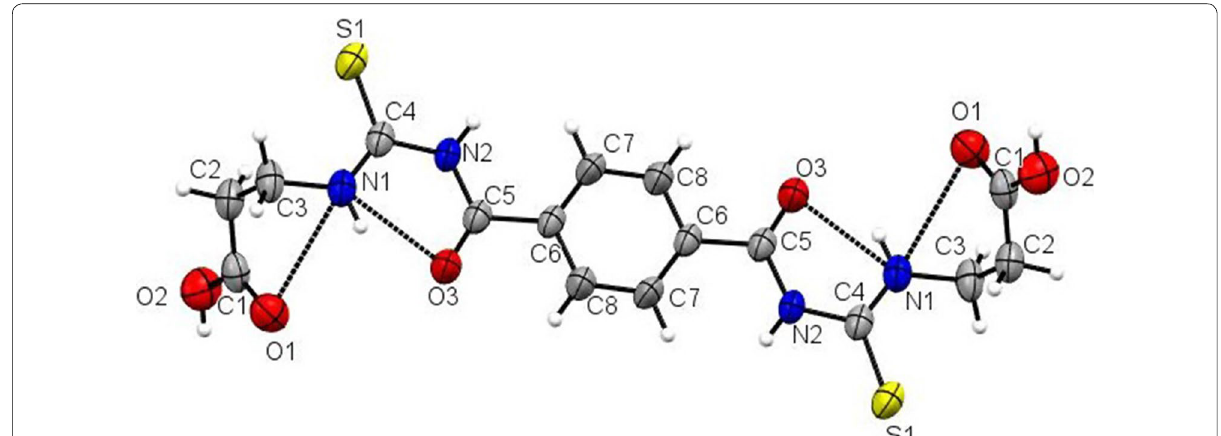
Fig. 1 ORTEP diagram of the 3, 3 ′ -[{(terephthaloylbis(azanediyl)bis(carbonothioyl)bis (azanediyl)}dipropanoicacid]. 1B was drawn at 50% probability displacement ellipsoids. The dashed line indicates the intramolecular hydrogen